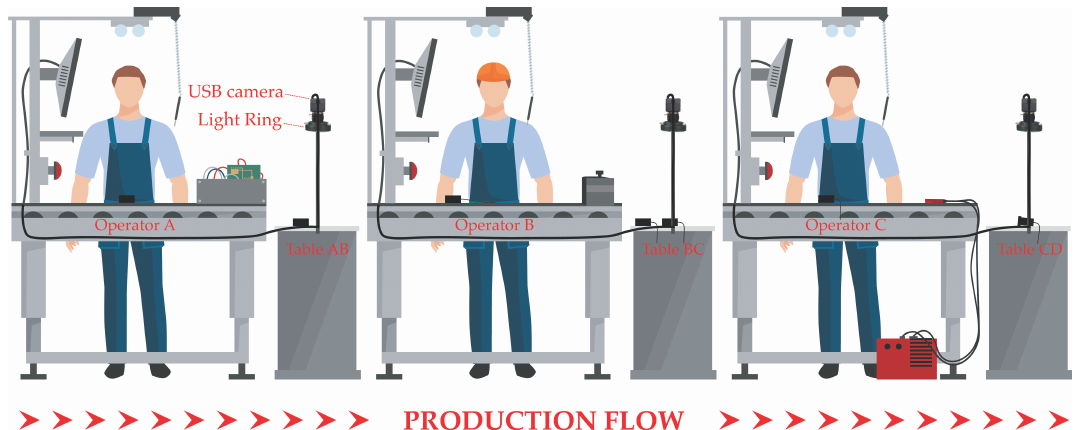
Figure 1. Detailed configuration of the ideal system set up in one sample assembly line.